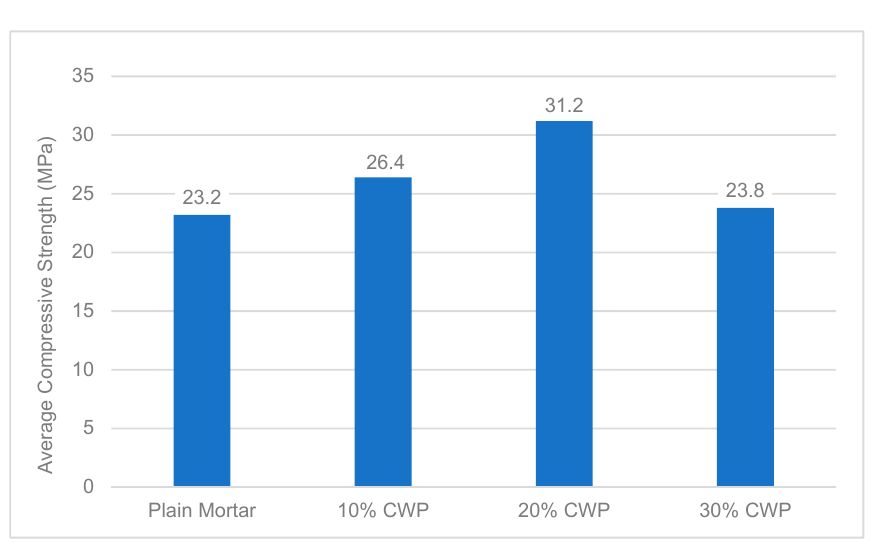
Figure 10. Variation of compressive strength of hydraulic cement for samples containing various dosages of CWP compared to a plain mortar mix.